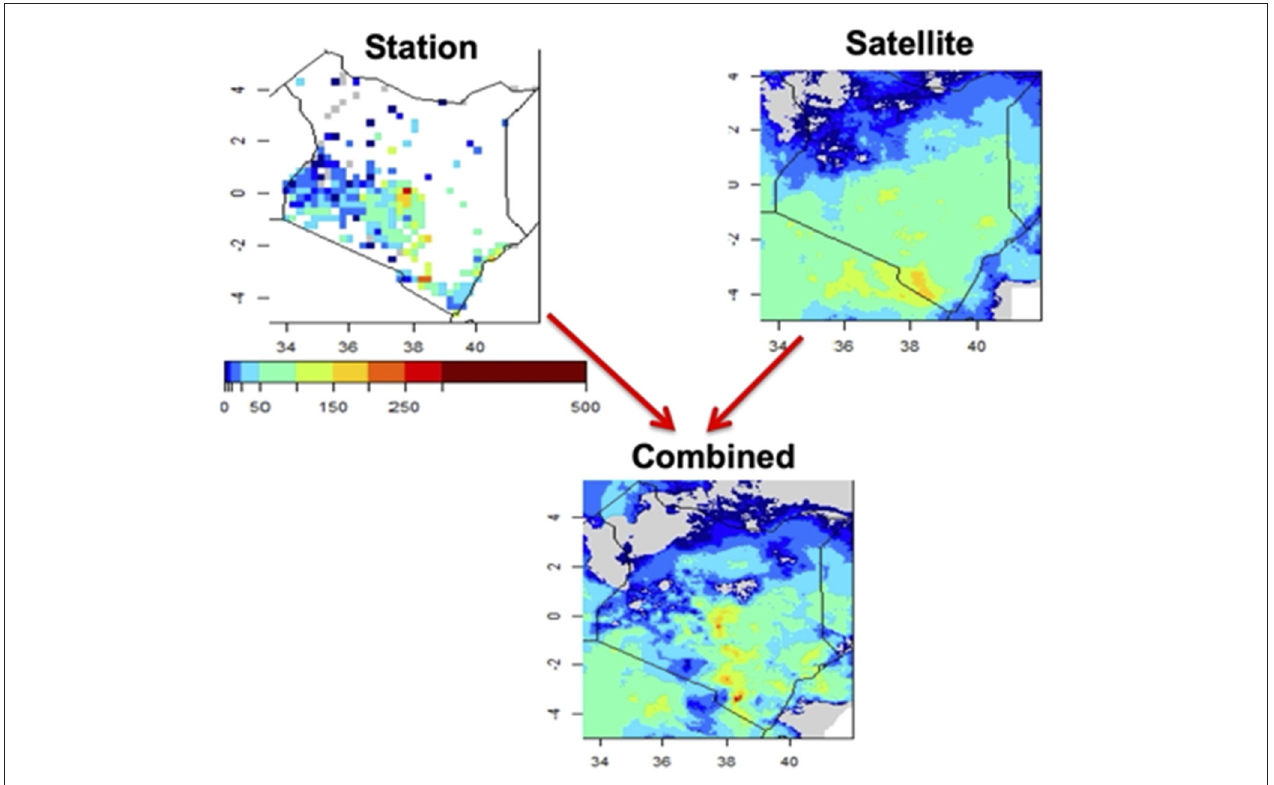
FIGURE 5 | Ten-day total rainfall as observed by station (top left), estimated by satellite (top right), and the optimal combination of the two (bottom). The color bar shows rainfall amounts in